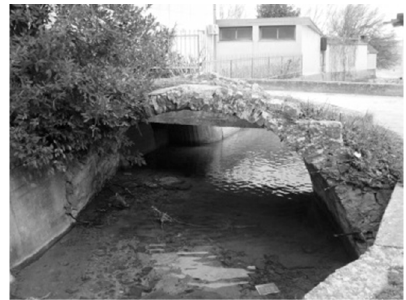
Figure 6. Castel Vitturi, Kaštel Lukši ć (B3). Figure 7. Ć osi ć mill, Grab (B4). Figure 8. Samar đ i ć mill, Grab (B5).